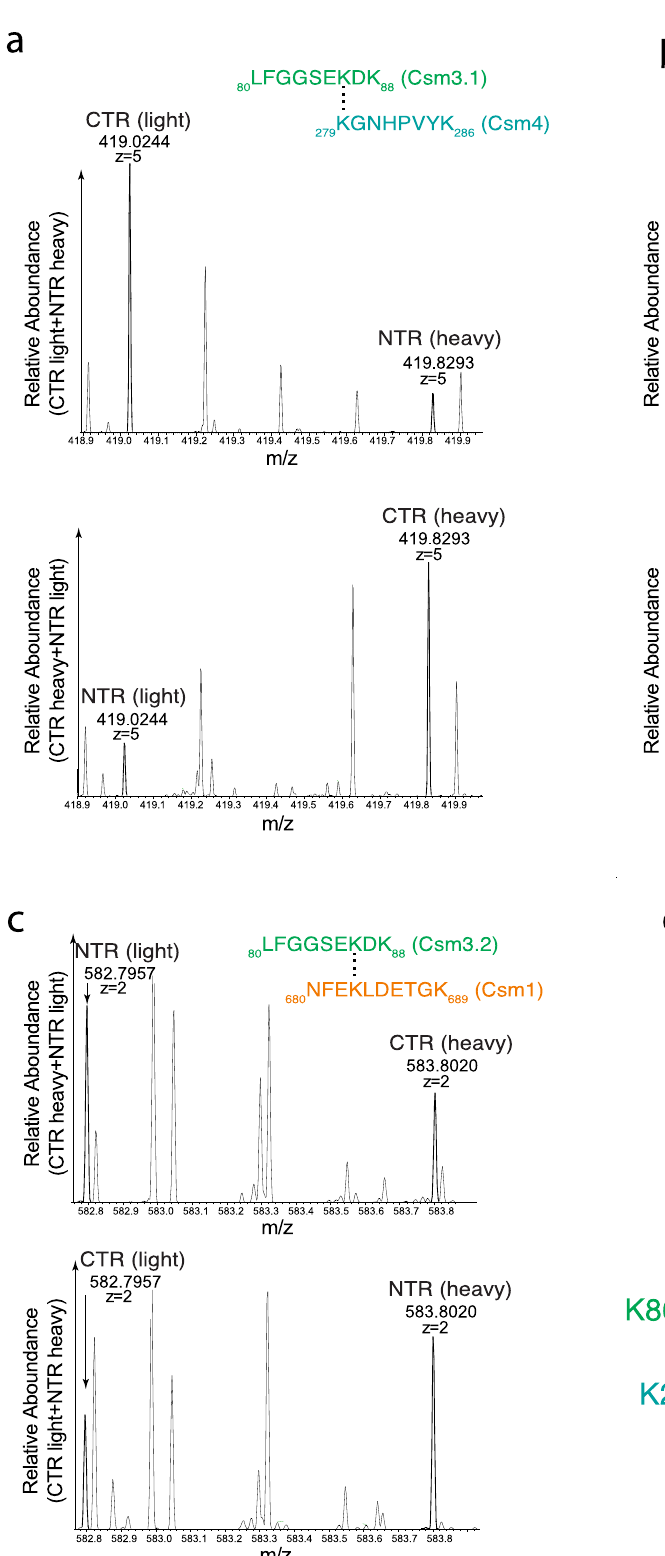
were performed in RELION-3.0 49 provide the UCSF MotionCor2 50 and Gctf wrapper 51 . Particles were auto-picked using the LoG-based auto-picking algorithm implemented in RELION-3 49 . The stack was created and imported into cryoSPARC 52 for 2D classi fi cation in order to eliminate bad particles. The reso- lution was estimated using the gold-standard Fourier Shell Correlation plot at the value of 0.143. Local resolution was estimated using Resmap 53 . All images were collected at ×81,000 magni fi cation with 1.074 Å/pixel sampling rate at the